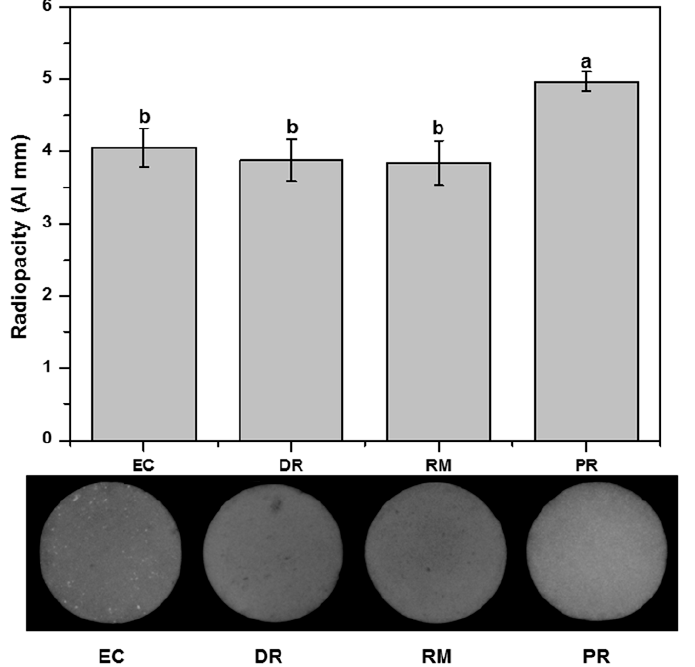
Figure 2. The radiopacity of the specimens was expressed as the equivalent thickness of aluminum (mm Al), and radiographic images of the specimens were obtained. The same lowercase letters indicate statistically significant differences ( p < 0.05).